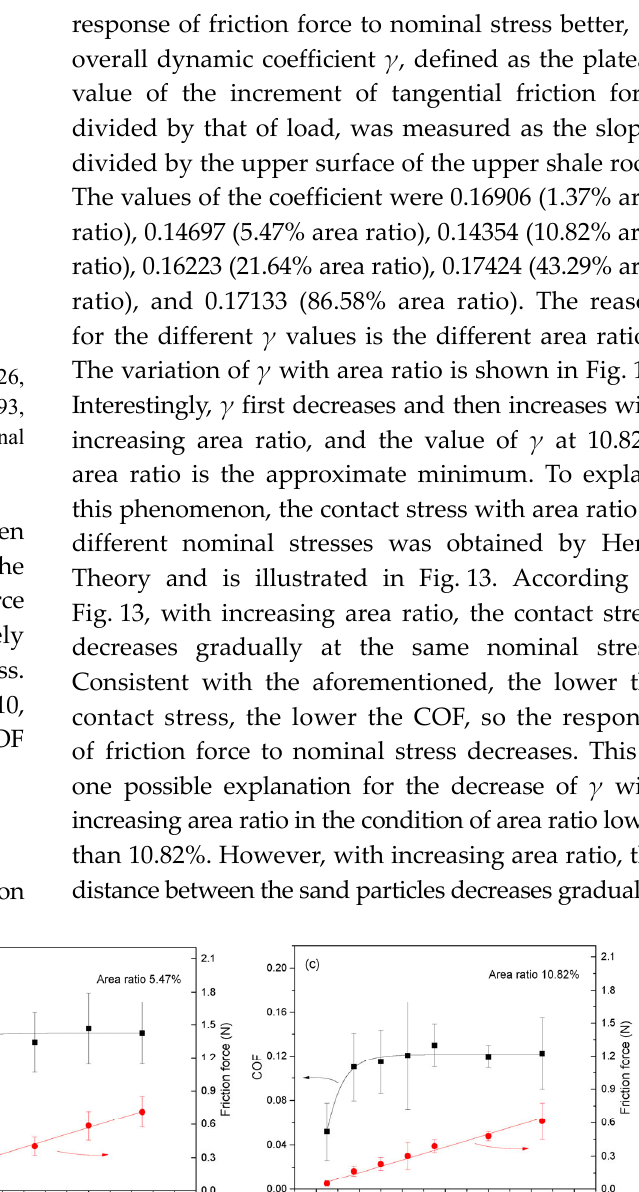
| https://mc03.manuscriptcentral.com/friction